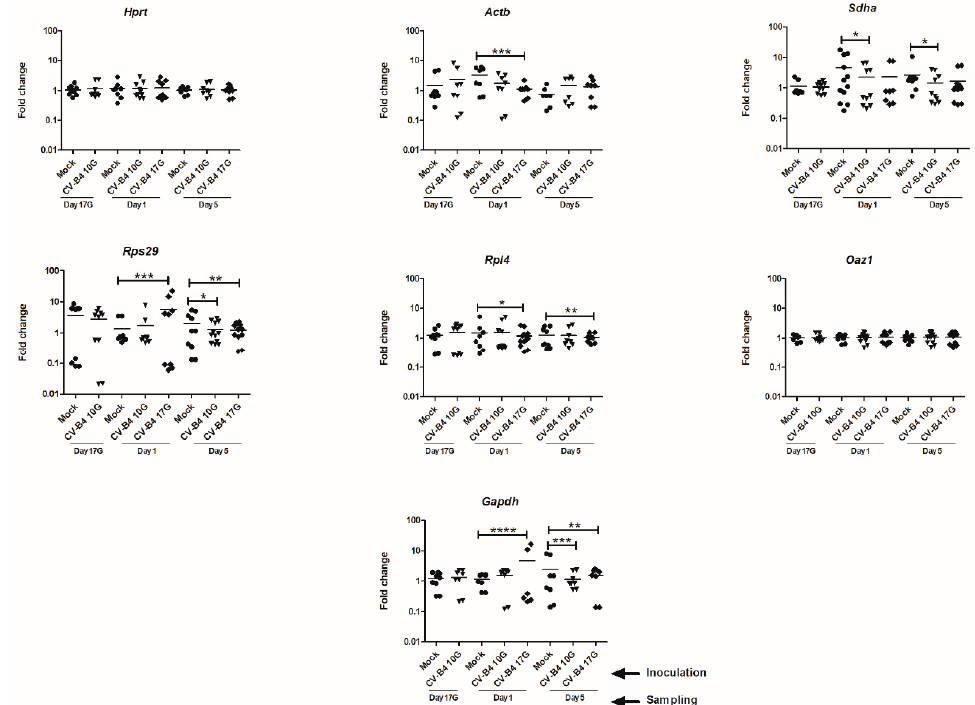
Figure 2. Fold change of seven candidate HKGs in CV-B4-infected compared to mock-infected thymus. Expression levels for each gene are represented by log-scale of fold change (lines represent a median) in mock- ( ● ) and CV-B4-infected thymuses ( n = 6–13), sampled at different time points, from fetuses at Day 17 of gestation (Day 17G), and newborns at Day 1 and Day 5 from birth. CV-B4 10G ( ▼ ): thymus sampled from mice born to dams inoculated with CV-B4 at Day 10 of gestation; CV-B4 17G ( ♦ ): thymus sampled from mice born to dams inoculated with CV-B4 at Day 17 of gestation. Variances in CV-B4- versus mock-infected samples were compared using the unpaired t -test. A p value < 0.05 was considered statistically significant. * p value < 0.05, ** p value < 0.01, *** p value < 0.001, **** p value < 0.0001.